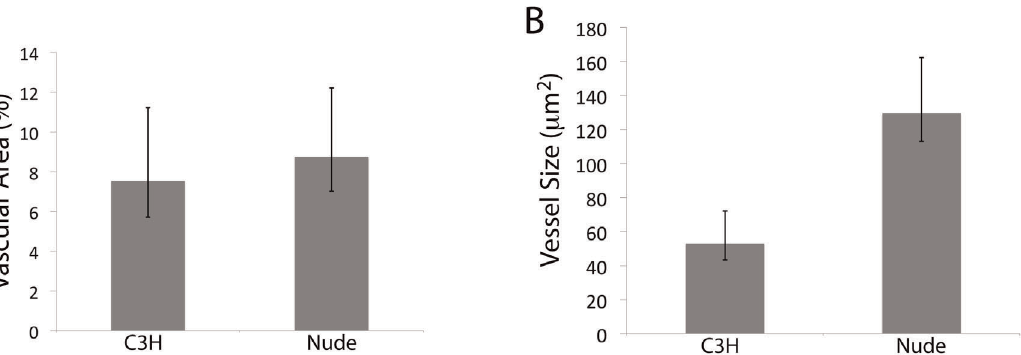
Figure 6. Tumor vascular structure is also strain-dependent. (A) Vascular area (as a percent of the tumor) and (B) median vessel size in the tumors of animals of each strain. Vessels were stained by immunochemistry for CD31 in sections collected from each of 4 and 5 tumors from C3H and nude mice, respectively; p=0.02 for the difference in vessel size between the models. Error bars indicate standard deviations.